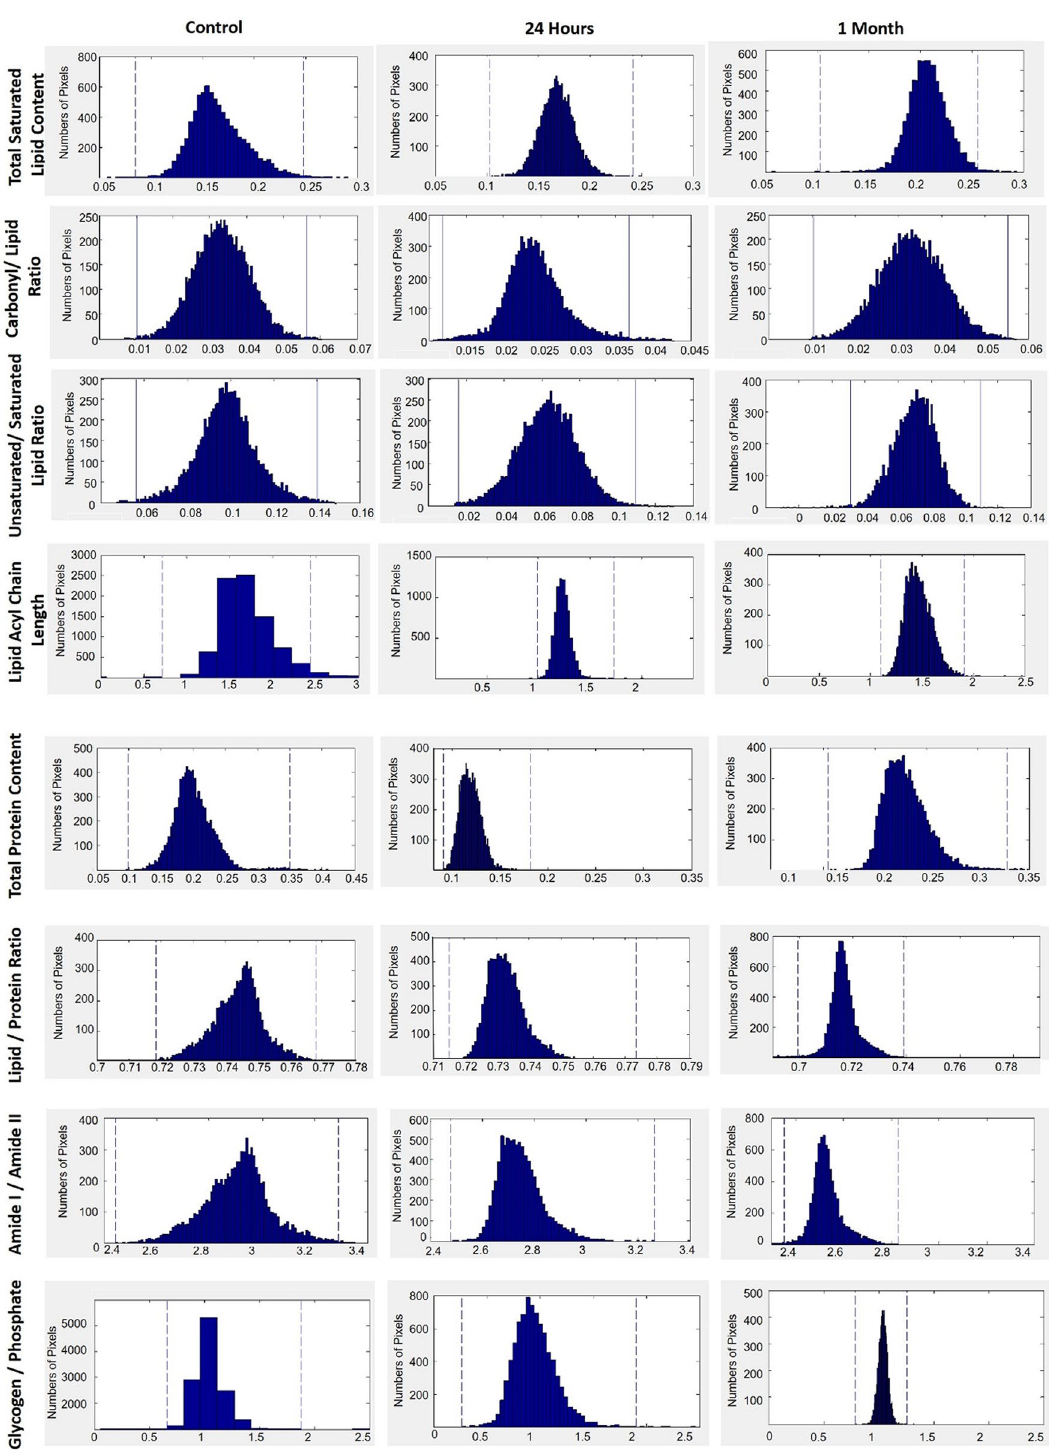
Figure 3. The pixel histograms for the FTIR images of total lipid content, carbonyl/lipid, unsaturated/saturated lipid, lipid acyl chain length, total protein content, lipid/protein, amide I/amide II and glycogen/phosphate ratios shown in Fig. 2 in hippocampal tissue of control, 24 h and 1-month TBI